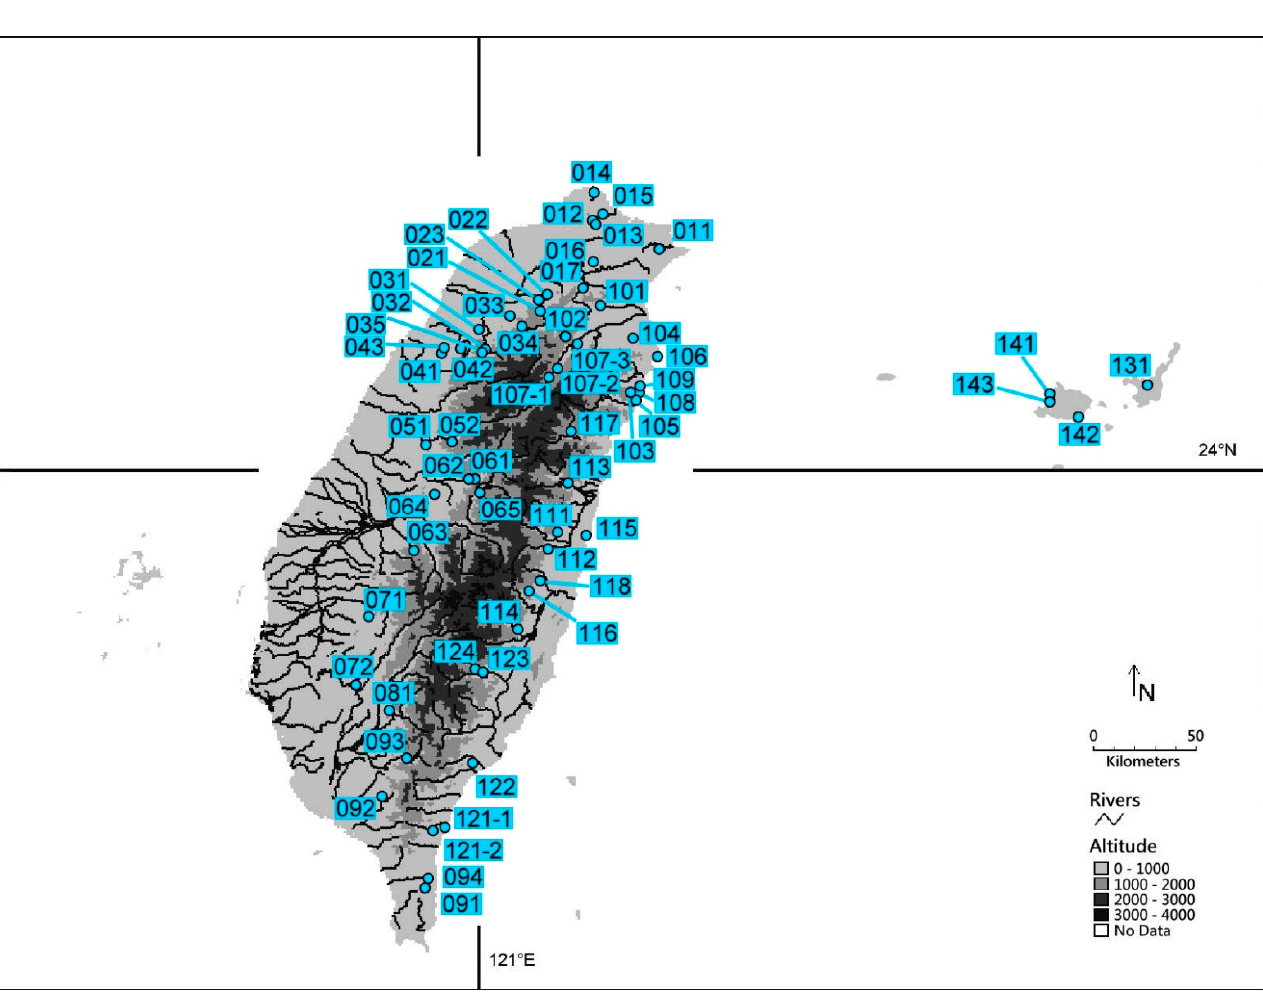
Figure 2. Distribution of sampling locations of P. madarinus in Taiwan and P. kuroiwae in Japan. Sampling locations are marked with open circles. The numbers of sampling locations are the same as in Table 2. The map was made using DIVA-GIS (https://www.diva-gis.org/; accessed on 1 June 2016). Table 2. Sampling localities and their haplotype information.